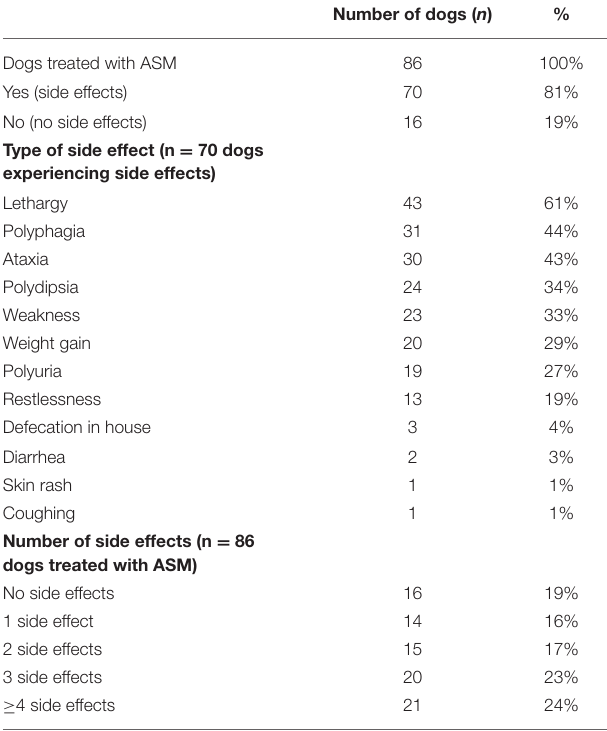
TABLE 2 | Side effects of antiseizure medication (ASM)